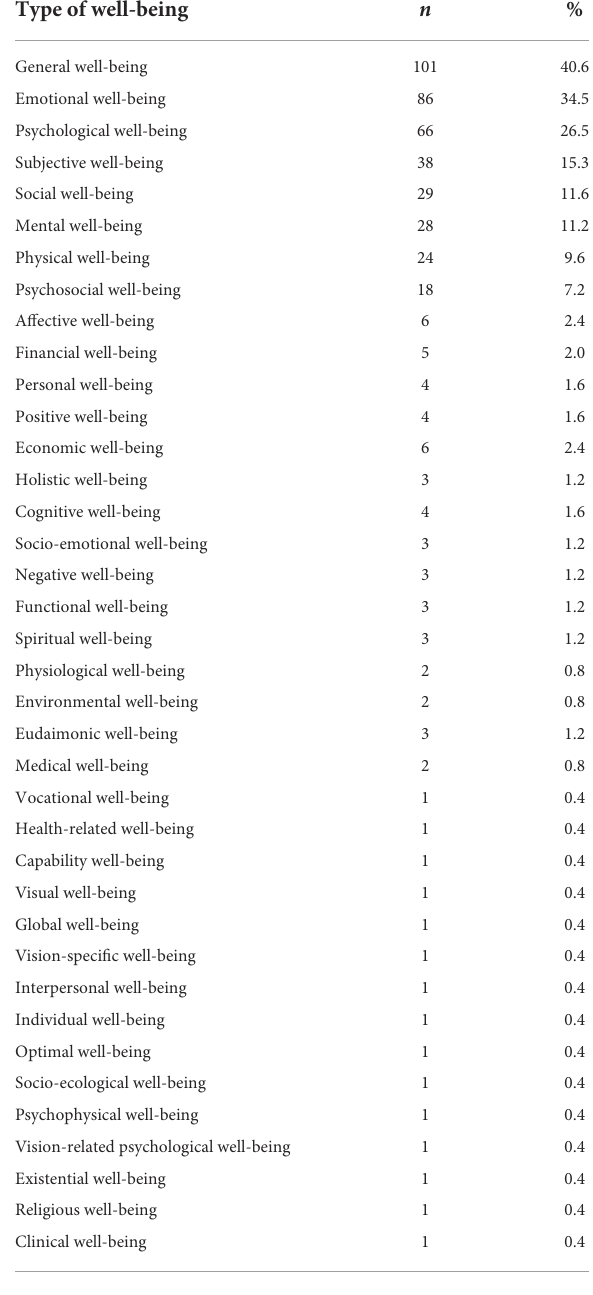
TABLE 1 Overview of domains and indicators included in each domain.